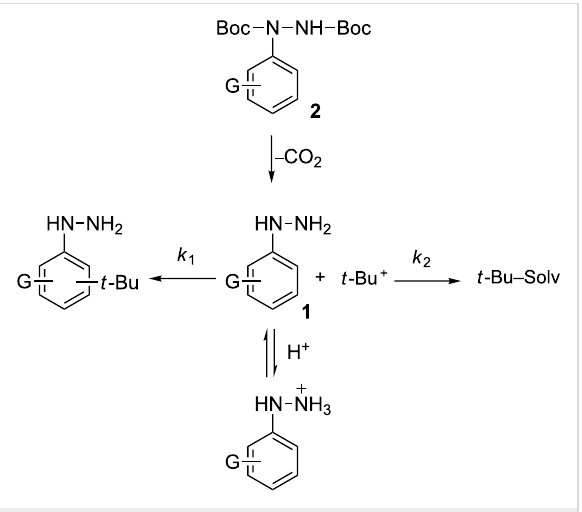
The nucleophilicity of the hydrazine can be suppressed by